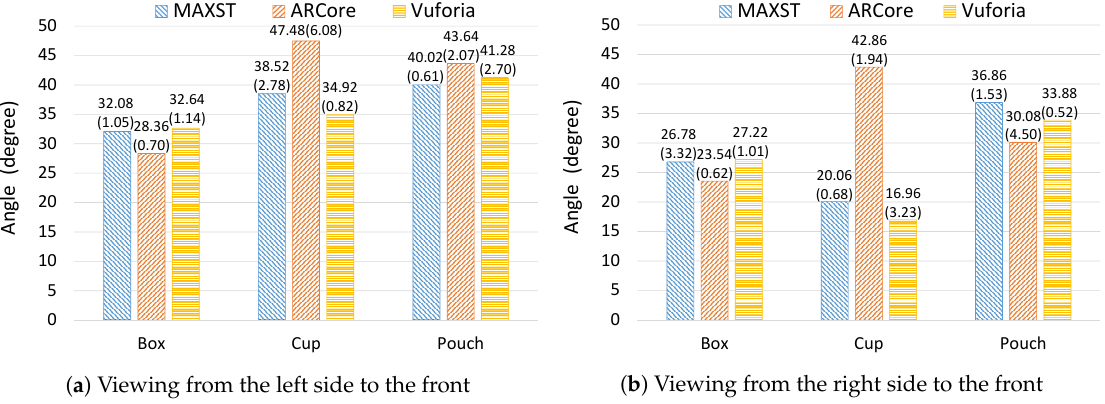
Figure 6. Minimum recognizable viewing angle (numbers inside parentheses are standard